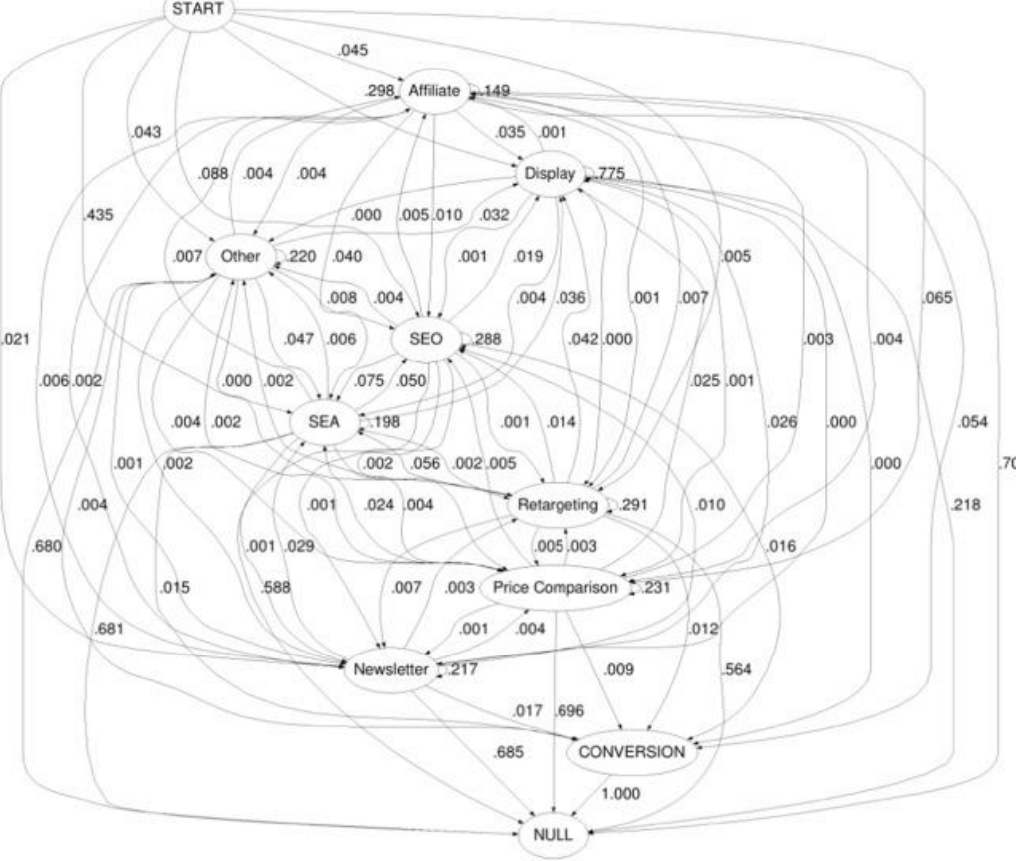
Figure 3. CJM presenting the level of significance between the touch points [39].